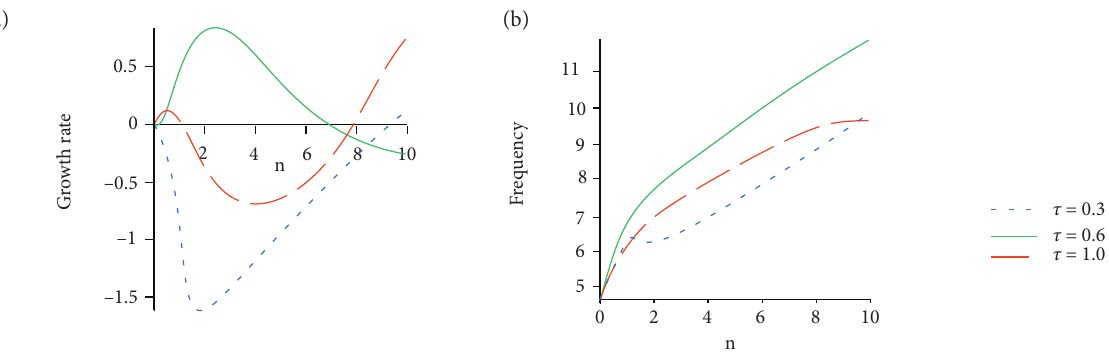
Figure 6. Thermoacoustic characteristics of a duct (3L mode, x